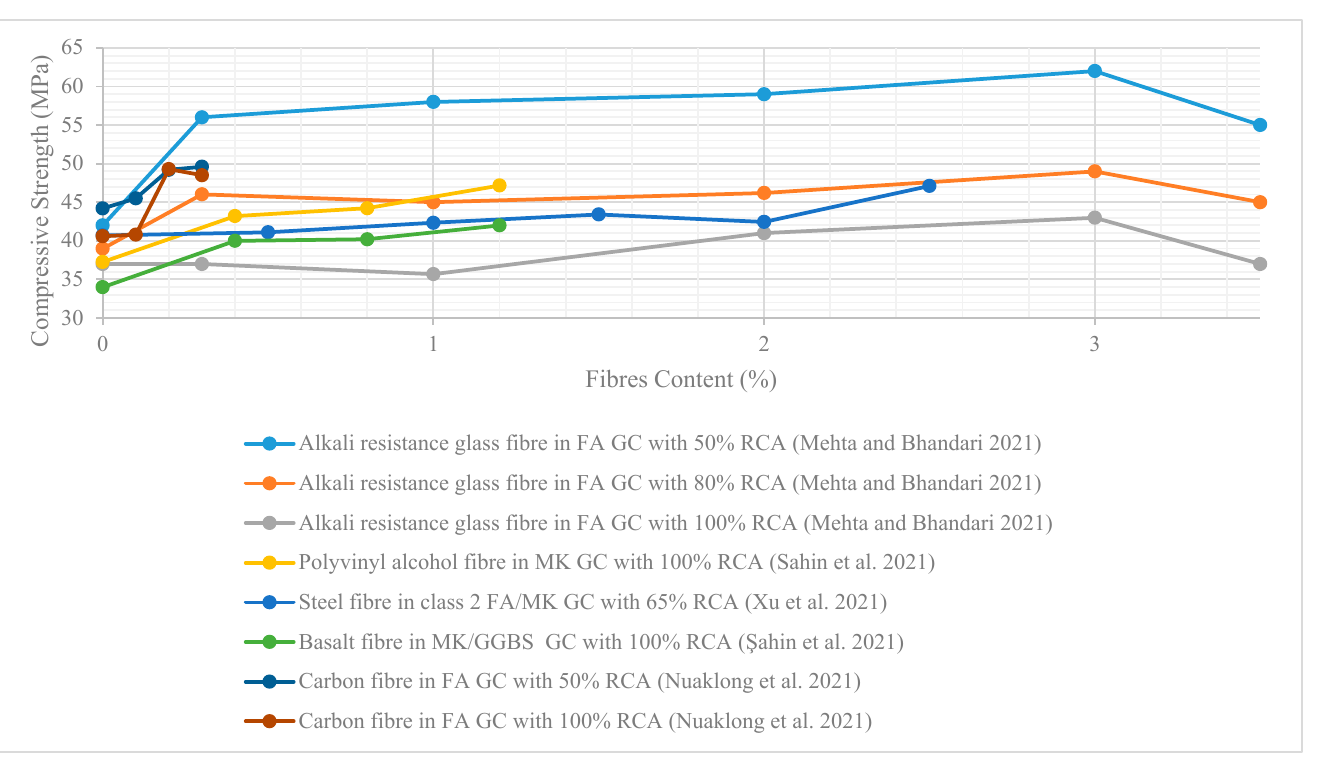
Fibres Content (%) Alkali resistance glass fibre in FA GC with 50% RCA (Mehta and Bhandari 2021) Alkali resistance glass fibre in FA GC with 80% RCA (Mehta and Bhandari 2021) Alkali resistance glass fibre in FA GC with 100% RCA (Mehta and Bhandari 2021) Polyvinyl alcohol fibre in MK GC with 100% RCA (Sahin et al. 2021) Steel fibre in class 2 FA/MK GC with 65% RCA (Xu et al. 2021) Basalt fibre in MK/GGBS GC with 100% RCA (Şahin et al. 2021) Carbon fibre in FA GC with 50% RCA (Nuaklong et al. 2021) Carbon fibre in FA GC with 100% RCA (Nuaklong et al. 2021) Figure 5. Relationship between fibre content and CS [32,37,44,60,70]. Figure 5. Relationship between fibre content and CS [32,37,44,60,70]. The iron filling also increases the compressive strength of an MK RCA-based GC by Polyvinyl alcohol (PVA) fibres are another fibre used as an additive in an MK RCA- based GC. The addition of 1.2% PVA increased the compressive and flexural strengths 2%, 5%, and 10% for 0.5%, 0.75%, and 1% iron filling, respectively. It also enhances the of RCA-based GC by 26.6% and 83.8%, reaching 47.17 MPa and around 9 MPa, respec- splitting tensile strength, flexural tensile strength, and modulus of elasticity by 32%, 42%, tively [32]. In like manner, Xu, Huang, Liu, Deng, Hui, Deng, Zhao, and Qin [60] used steel and 11%, respectively, for 1% iron filling. Iron filling fills the pores and improves the con- fibre in a FA/MK-based geopolymer with RCA. They observed that 28-day compressive crete’s internal structure [64]. strength, tensile strength, and flexural strength increased by 15.72%, 64.1%, and 60.95%, respectively, reaching 47.11 and 5.12, and 7.79 MPa, respectively, while it contained